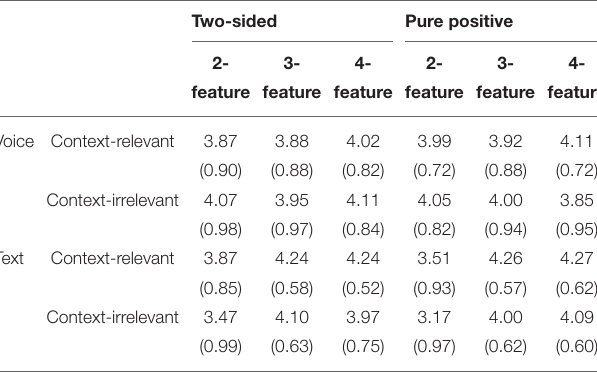
TABLE 6 | (Formal study) User satisfaction (after aggregation) with the TABLE 5 | (Formal study) Spearman’s correlations among perceived explanation effectiveness , perceived recommendation transparency , and user satisfaction . recommender system regarding the explanation’s output modality, feature type, contextual relevance, and the number of features (Mean, and SD in the Effectiveness Transparency Satisfaction